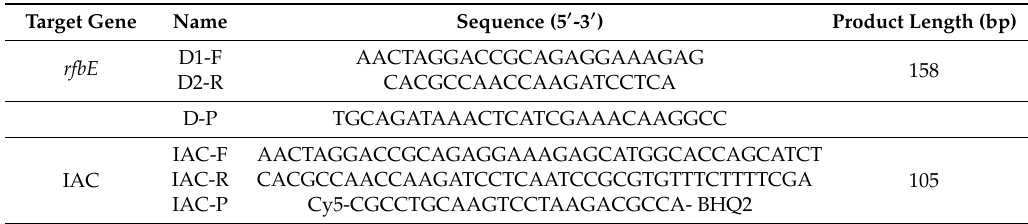
Table 1. The primers and TaqMan probes used for